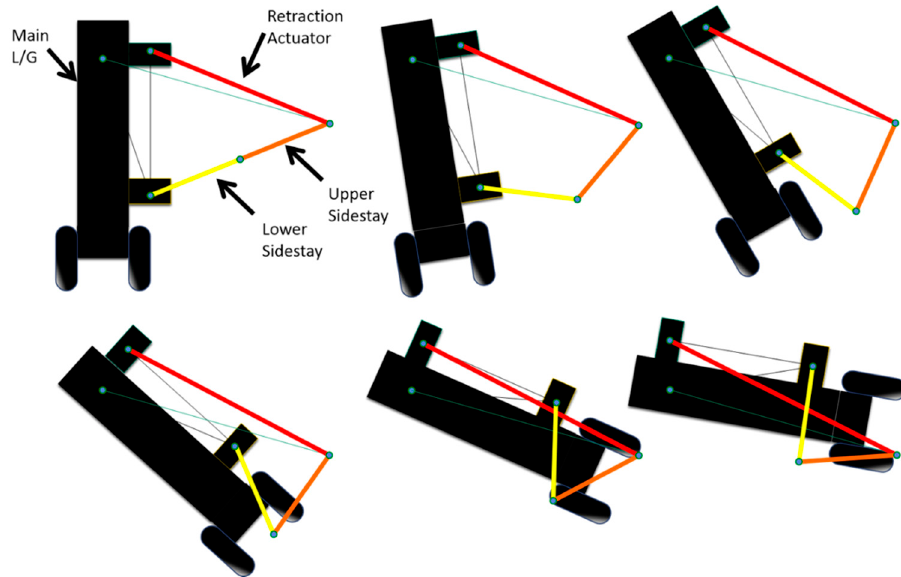
Figure 2. Structure diagram of Hawker 800XP aircraft main landing gear.